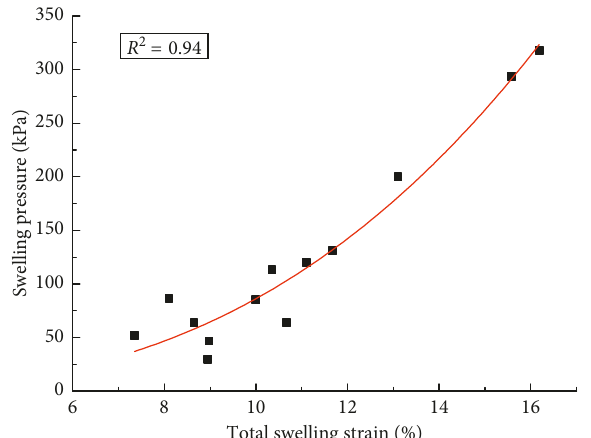
Figure 22: Relationship of measured expansive stress and ex- pansive stress predicted by this